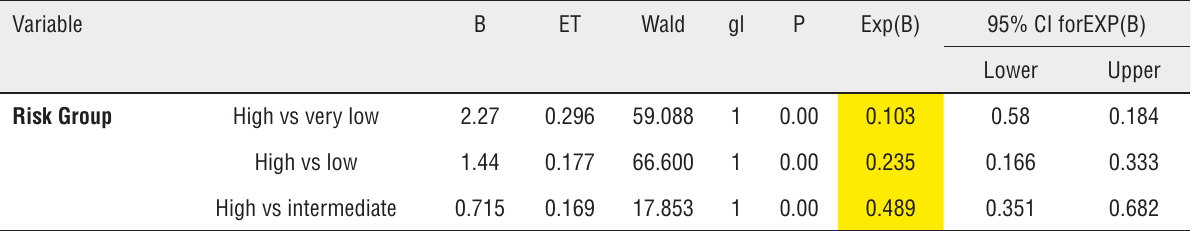
Table 7 - Subvariables that retain independent statistical significance for PFS.